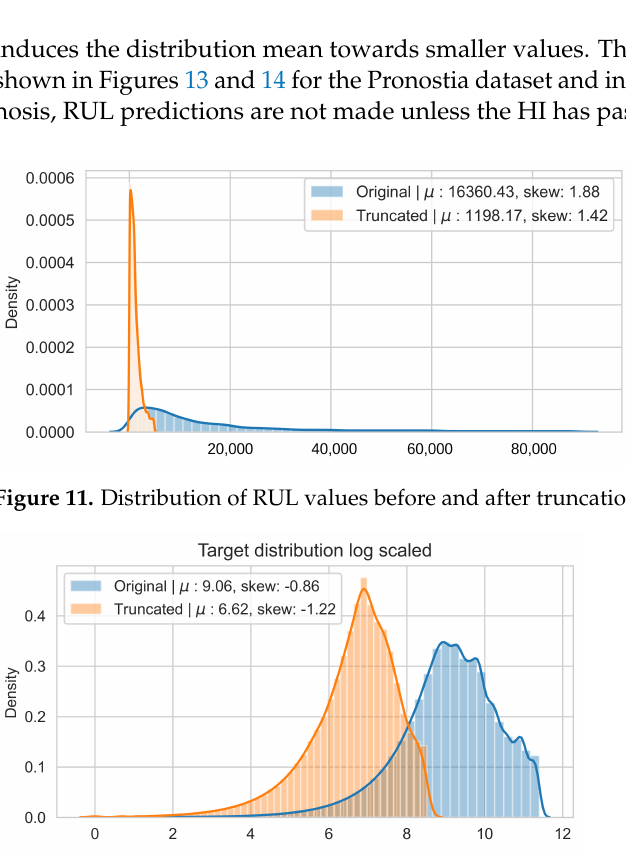
Figure 12. Distribution of log-transformed RUL values before and after truncation for the SMLL bearings.